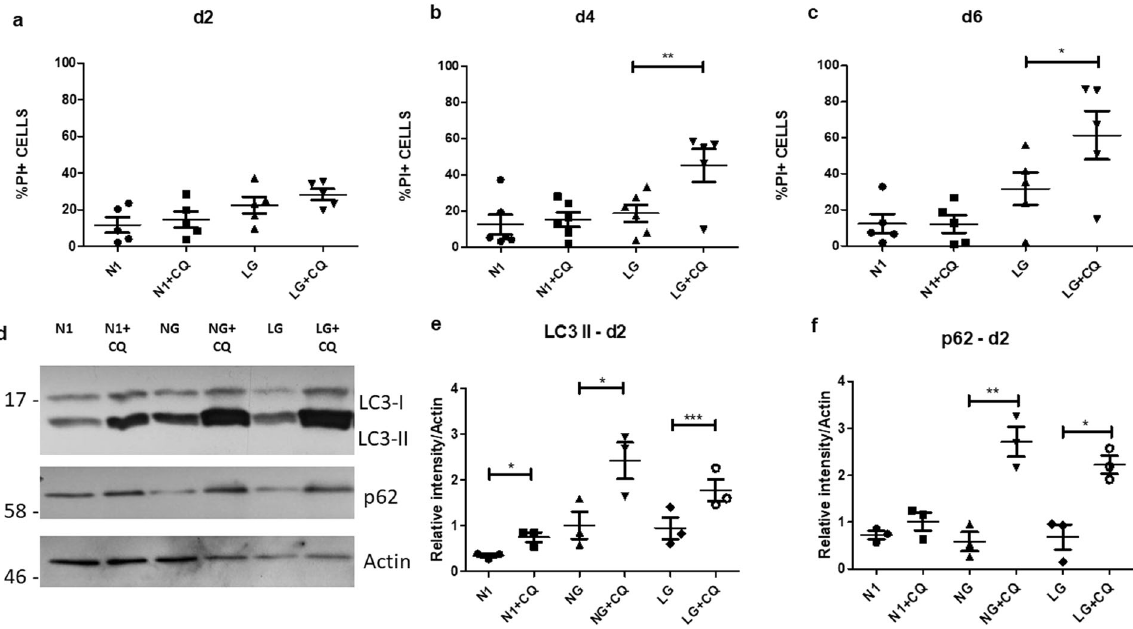
Fig. 6 Contribution of the autophagy pathway to protecting OLs from metabolic injury. a – c Protective effects of autophagy in human adult OLs. Cell death measured by % PI + cells of human adult OLs cultured in optimal culture media (N1), in low glucose media (LG) and in combined treatment with chloroquine (N1 + CQ; LG + CQ) after two ( a ), four ( b ) and six days ( c ). Addition of CQ results in increase % PI + cells at day 4 and 6. N = 5 independent biological samples. d – f Representative western blot for the combined treatment of N1, LG, and NG with and without chloroquine after two days ( N = 3 independent biological samples) ( d ) and quanti fi cation of the relative expression compared to actin of LC3 II ( e ) and p62 ( f ). Mean± SEM for each condition in the fi gure. Statistical signi fi cance was veri fi ed by ANOVA/Tukey test: *(<0.05), **(<0.01),